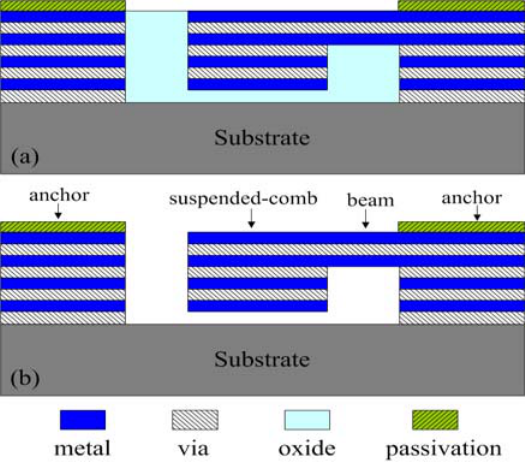
Figure 10. A-A cross section of the tunable resonator; (a) after completion of the CMOS process, (b) after completion of the post-process.